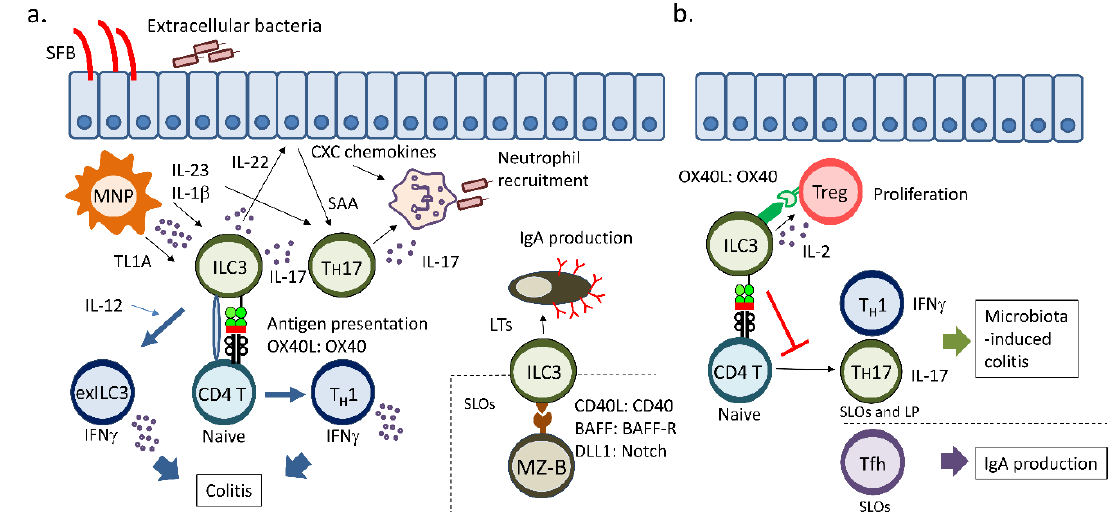
Figure 4. ILC3s control subsequent acquired immunity. ( a ) ILC3s augment T H 1 and T H 17 di ff erentiation. Colonization of segment filamentous bacteria (SFB) enhances T H 17 di ff erentiation through ILC3-derived IL-22 that induces intestinal epithelial cells to secrete serum amyloid A (SAA) for T H 17 di ff erentiation. ILC3s present antigens to naïve CD4 + T cells and elicit T H 1 di ff erentiation in colitis. NCR + ILC3s acquire an ability to produce IFN- γ in an IL-12-dependent manner. ILC3s produce lymphotoxins (LTs) that support T-cell-dependent and -independent IgA production in the intestine. At secondary lymphoid organs (SLOs), ILC3s activate marginal zone B cells (MZ-B) by direct contact. ( b ) Immunosuppressive roles of ILC3s in regulating acquired immunity. ILC3s promote Treg expansion by IL-2 and OX40 / OX40L signaling. ILC3s suppress di ff erentiation of microbiota-specific T H 1 and T H 17 cells by antigen presentation without costimulatory signals. Similarly, Tfh-cell di ff erentiation in colon mesenteric lymph nodes is suppressed by ILC3s. LP: lamina propria.